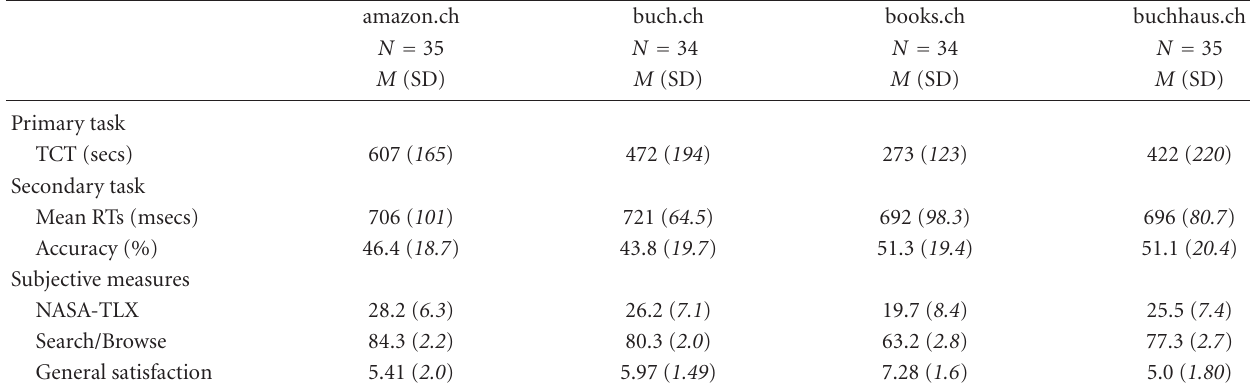
Table 2: Means and (Standard Deviations) for the six major outcome measures for each of the four shops.